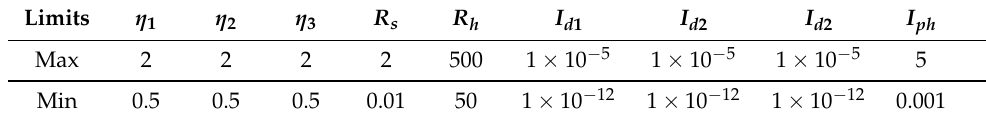
Table 1. Minimum and maximum limits to evaluate the Solarex MSX60 and Solar-SJ65 PV panels. Limits